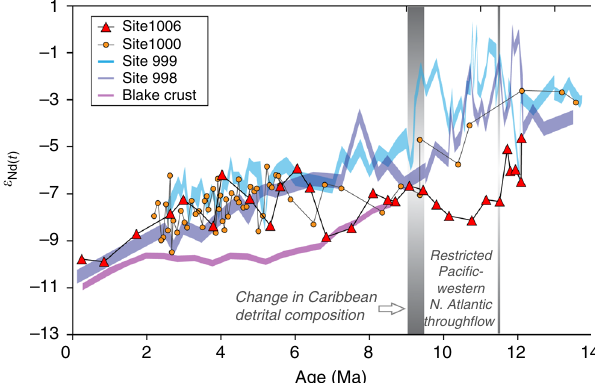
Fig. 2 Seawater Nd isotope records. Seawater ε Nd records ( ε Nd = [( 143 Nd/ − 1] × 10 4 , whereby CHUR stands for the 144 Nd 143 Nd/ 144 Nd (sample) /( (CHUR)